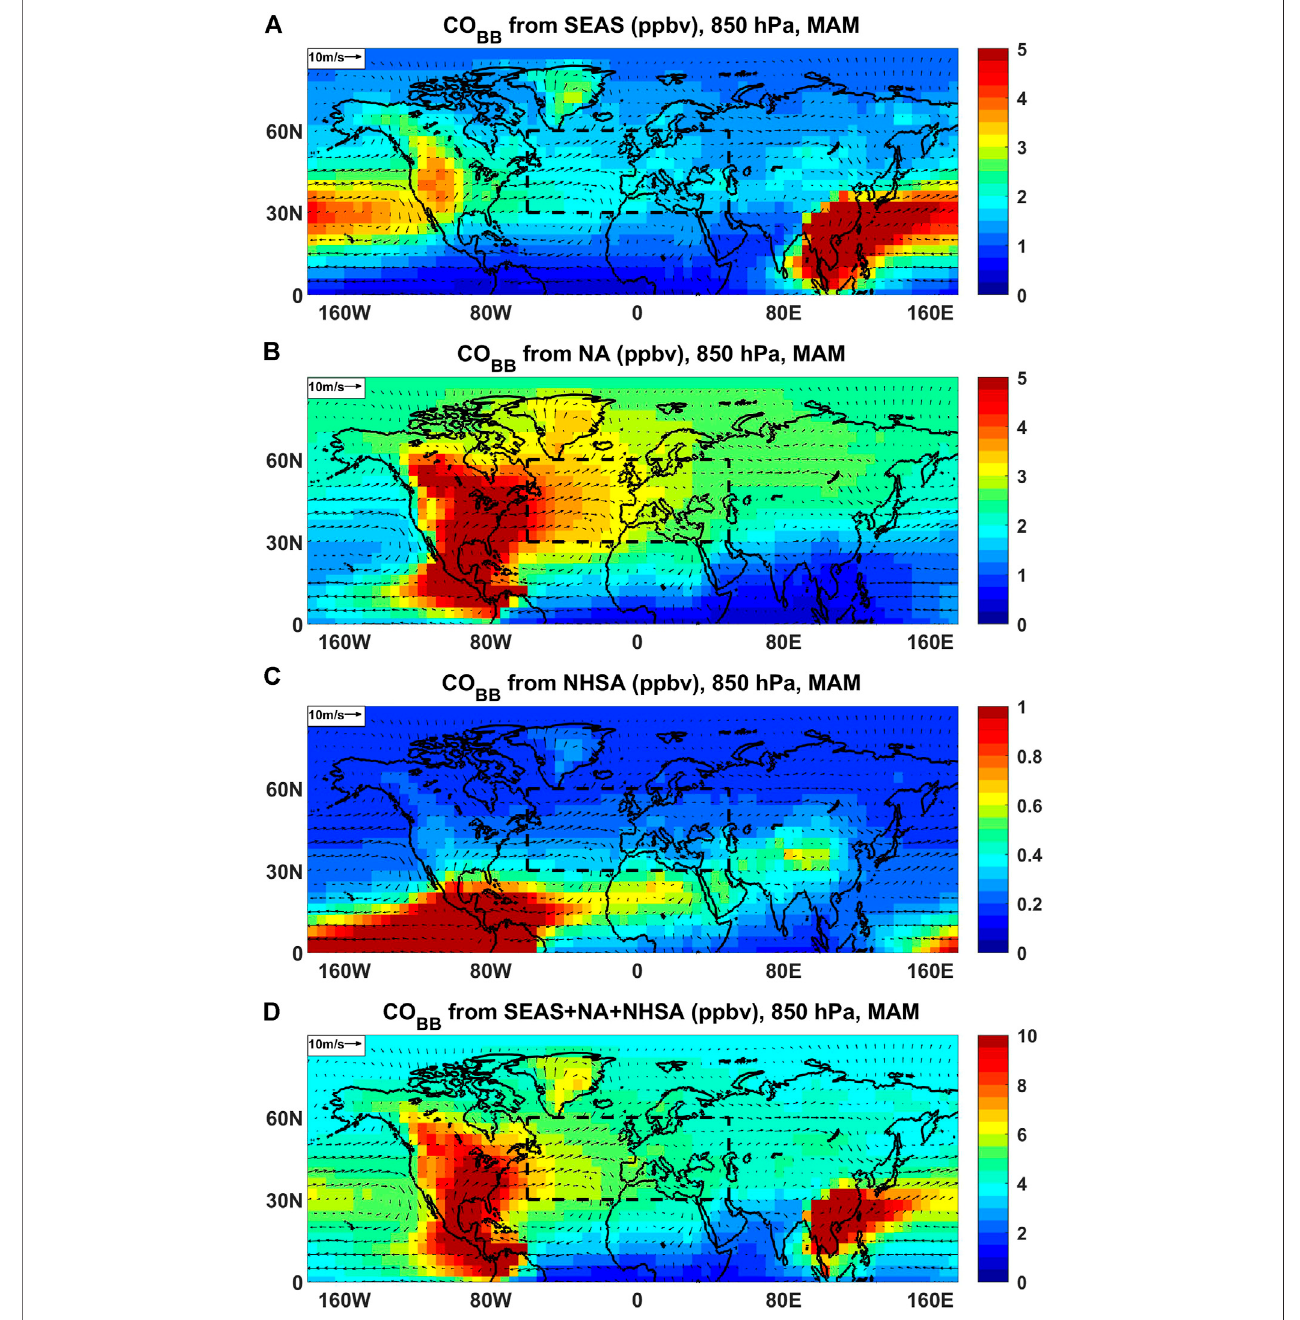
FIGURE 5 | GEOS-Chem tagged CO simulations at 850 hPa. (A) Spatial distribution of fi re-induced CO (CO BB , ppbv, in color) from Southeast Asia (SEAS) only, overlaid with the winds (arrows). (B) The same as (A) , but for CO BB from North America (NA) only. (C) The same as (A) , but for CO BB from Northern Hemispheric South America (NHSA) only. (D) The same as (A) , but for CO BB from Southeast Asia (SEAS), North America (NA), and NH Southern America (NHSA) in total. All values are averaged MAM CO concentrations over 2002 – 2019.